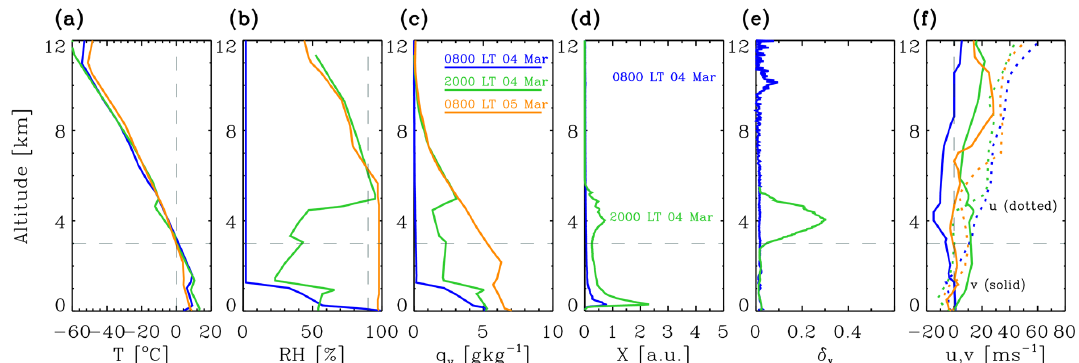
Figure 8. Sequential profiles of (a) temperature T , (b) relative humidity over liquid-water RH, (c) water vapor mixing ratio q v and (f) the east- ward u (dashed) and northward v (solid) wind components delivered by conventional radiosondes (twice daily) released on 4–5 March 2019 at the Wuhan weather station. The corresponding profiles of the (d) range-corrected signal X and (e) volume depolarization ratio δ v measured by the 355nm polarization lidar on 4 March 2019 are also shown. The different curve colors in each panel represent the radiosonde release times, as shown in panel (c) . Each colored lidar profile represents a 1h integration centered at the radiosonde release time shown in panel (d) . The radiosonde profiles quantitatively present the meteorological conditions pertinent to the warm-front clouds and precipitation.